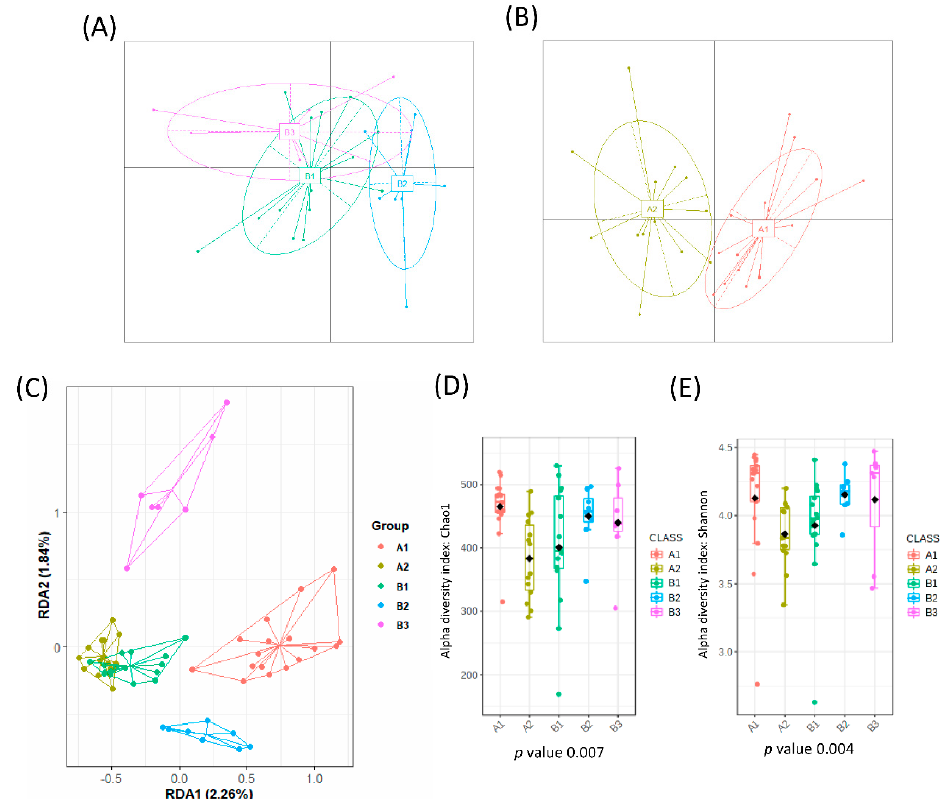
Figure 1. Microbial clusters and representative microbial taxa at the genus level. The partitioning around medoid method showed that volunteers were clustered at baseline into 3 groups ( A ) and into 2 groups after intervention ( B ) as reported in the Principal Coordinate Analysis (PCoA). ( C ) Multivariate redundancy discriminant analysis (RDA) showed distinct microbial communities for each group with the alpha diversity indexes: ( D ) richness (Chao1 index) and ( E ) diversity (Shannon index) depending on each cluster. Schemes follow the same formatting.